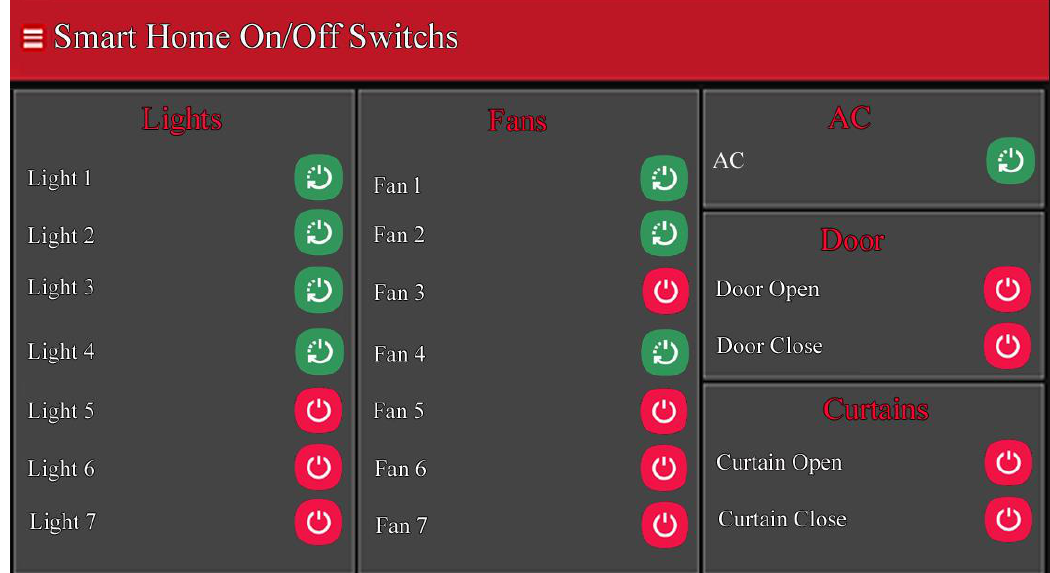
Figure 6. The interface to control home appliances where the red color buttons indicate that the appliances are off, and the green indicates the on status.